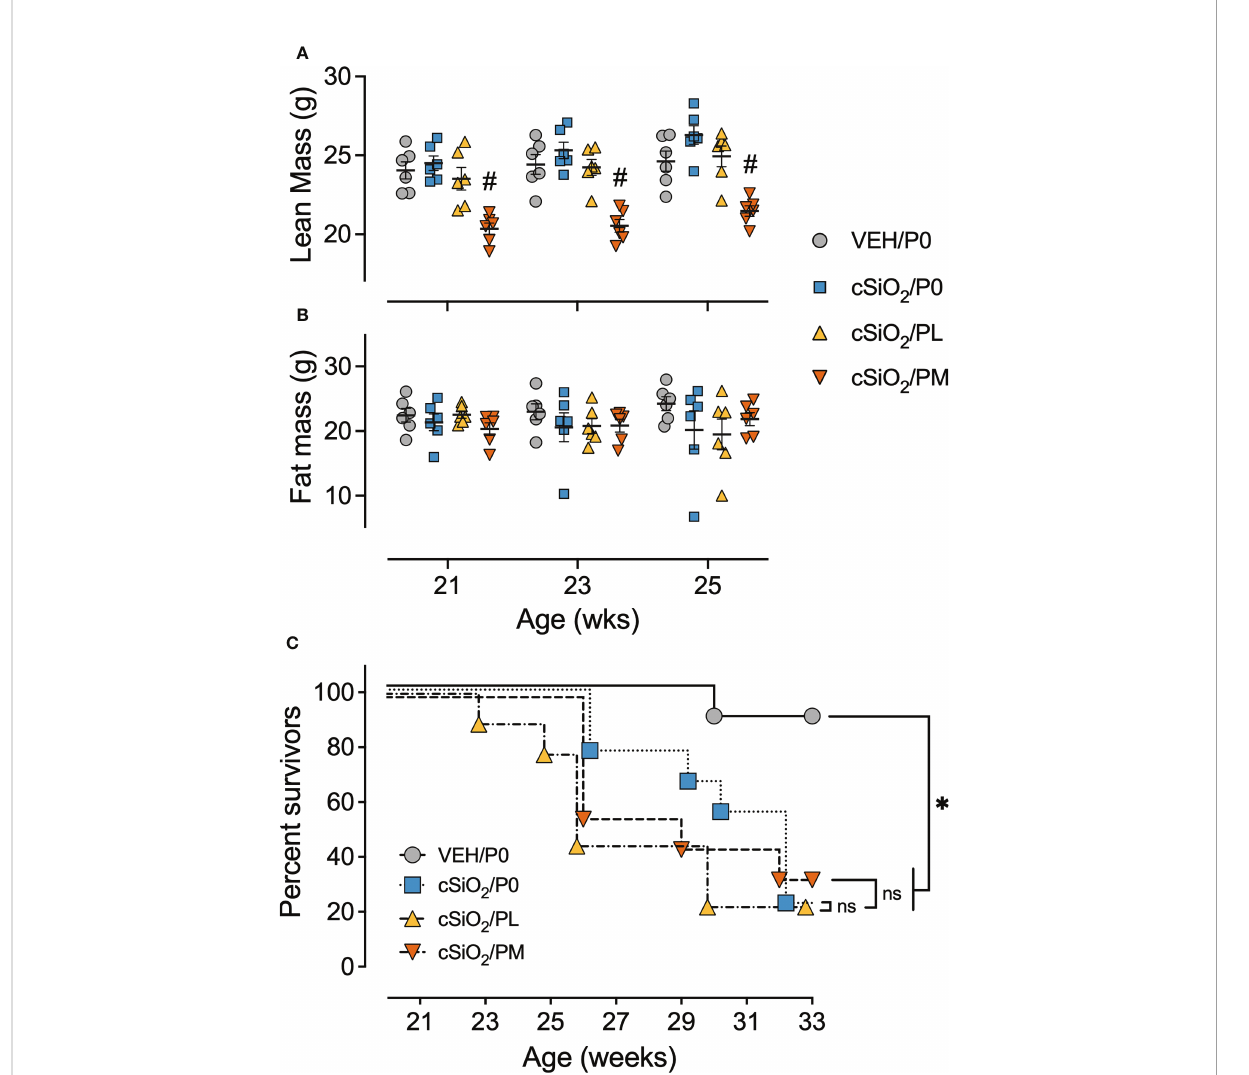
FIGURE 2 Moderate dose prednisone treatment signi fi cantly reduced lean muscle mass and did not improve survivability. Mice were evaluated for lean muscle (A) and fat mass (B) using EchoMRI at 21 wk of age (9 wk PI), 23 wk of age (11 wk PI), and 25 wk of age (13 wk PI). PM treatment induced signi fi cant lean muscle mass loss compared to cSiO 2 control mice. cSiO 2 and prednisone had no effects on fat mass. *Indicates p<0.05 for VEH/ P0 vs cSiO 2 /P0; # indicates p<0.05 for cSiO 2 /P0 vs cSiO 2 /PL or cSiO 2 /PM group as described in Materials and Methods. (C) Kaplan-Meier survival plot depicting survival of mice in cohort B which were evaluated weekly using moribund criteria. *Indicates p<0.05 for VEH/P0 group survival compared to cSiO 2 /P0, cSiO 2 /PL, or cSiO 2 /PM group survival as determined by the Mantel-Cox log-rank test. ns indicates not signi fi cant. No differences in survival between cSiO 2 /P0 and the cSiO 2 /PL or cSiO 2 /PM groups were